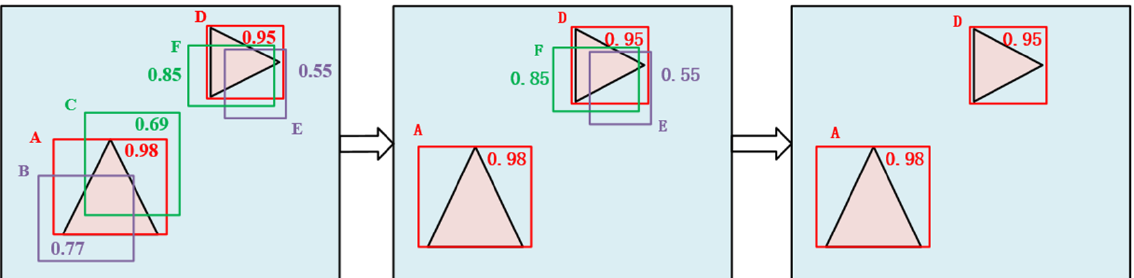
Figure 9. The schematic diagram of Non-Maximum Suppression (NMS).